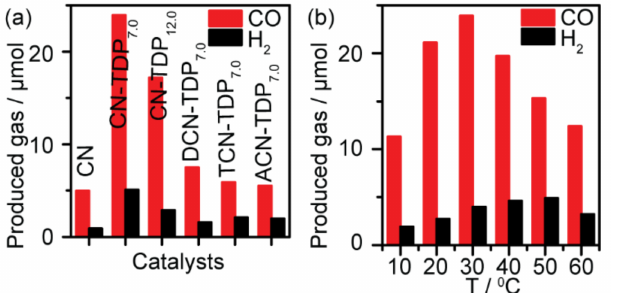
Figure 6. ( a ) CO 2 reduction reaction by using different catalysts for comparison. ( b ) Different organic solvent CO 2 reduction reactions at given conditions under visible light.